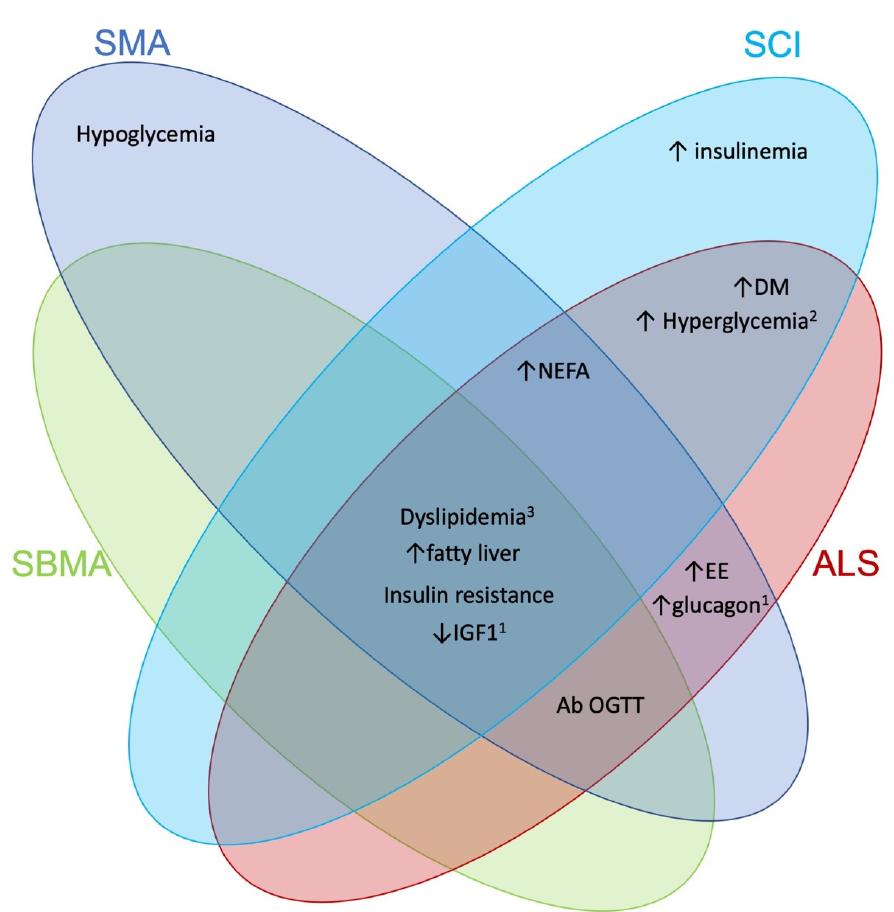
Figure 1. Common metabolic findings within neuromuscular disorders. Venn diagram